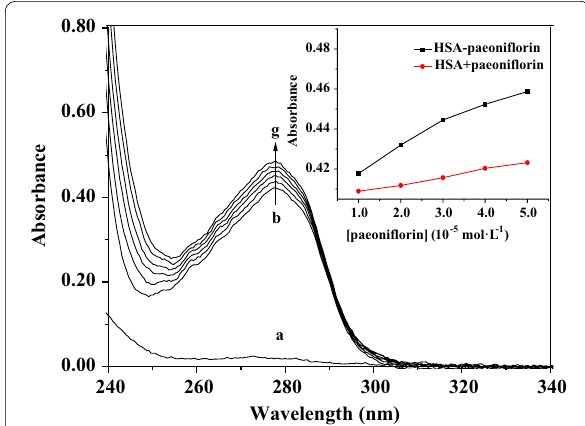
Fig. 4 Absorption spectra of paeoniflorin alone (a) and HSA in the presence of different concentrations of paeoniflorin (b–g); Inset: comparison of the absorption values at 280 nm between the HSA–paeoniflorin mixed solutions and the sum values of free HSA and free paeoniflorin, a: [paeoniflorin] [HSA] 1.0 10 − 5 mol L − 1 , [paeoniflorin] = ×